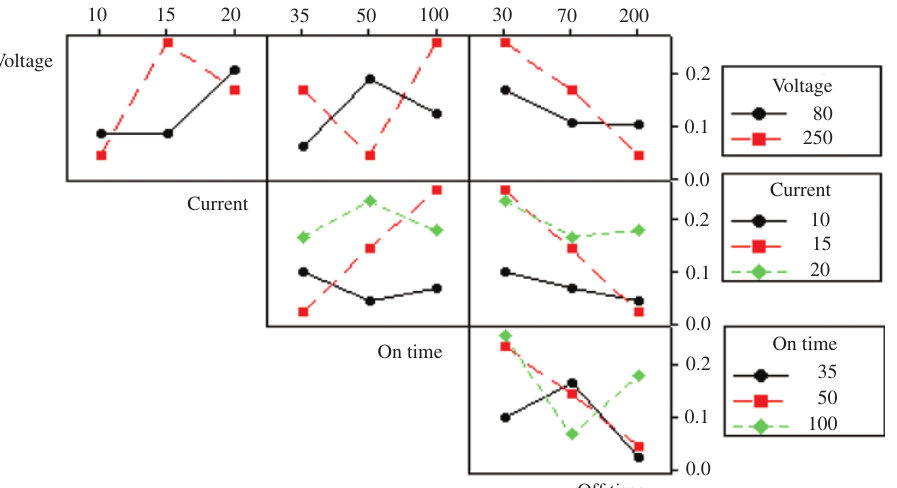
Figure 11: Interaction plot for the process parameters on TWR in the machining of 2024 alloy.